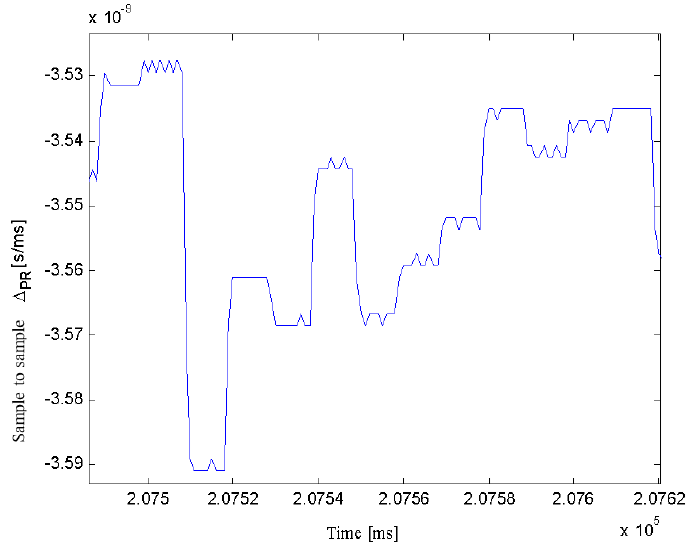
Figure 10. GPS L1 C/A LoS Variation (s) Observed every 1 ms Epoch, Based on 10 ms Non-Coherent Integration Time DLL Feedback Commands.